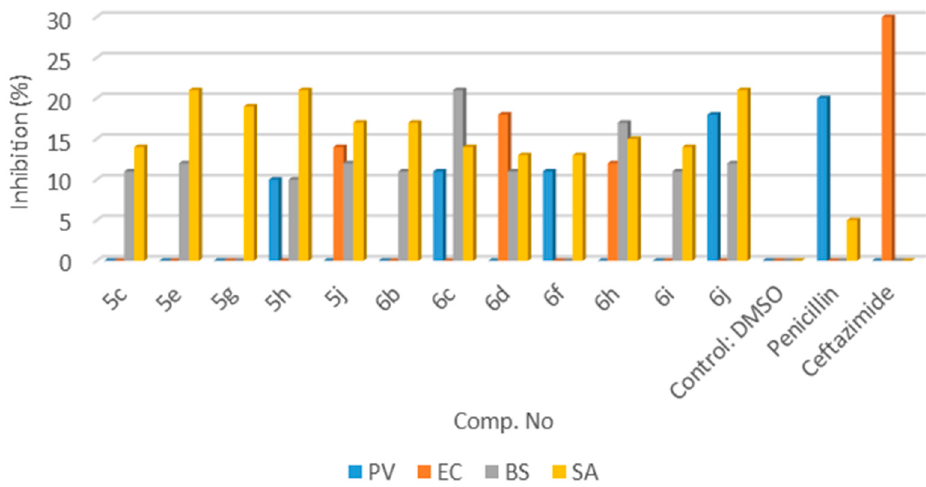
Figure 1. Antimicrobial activity of all synthesized compounds 5a – j and 6a – j . Table 3. Antimicrobial activity of all synthesized compounds 5a – j and 6a – j . Compd.